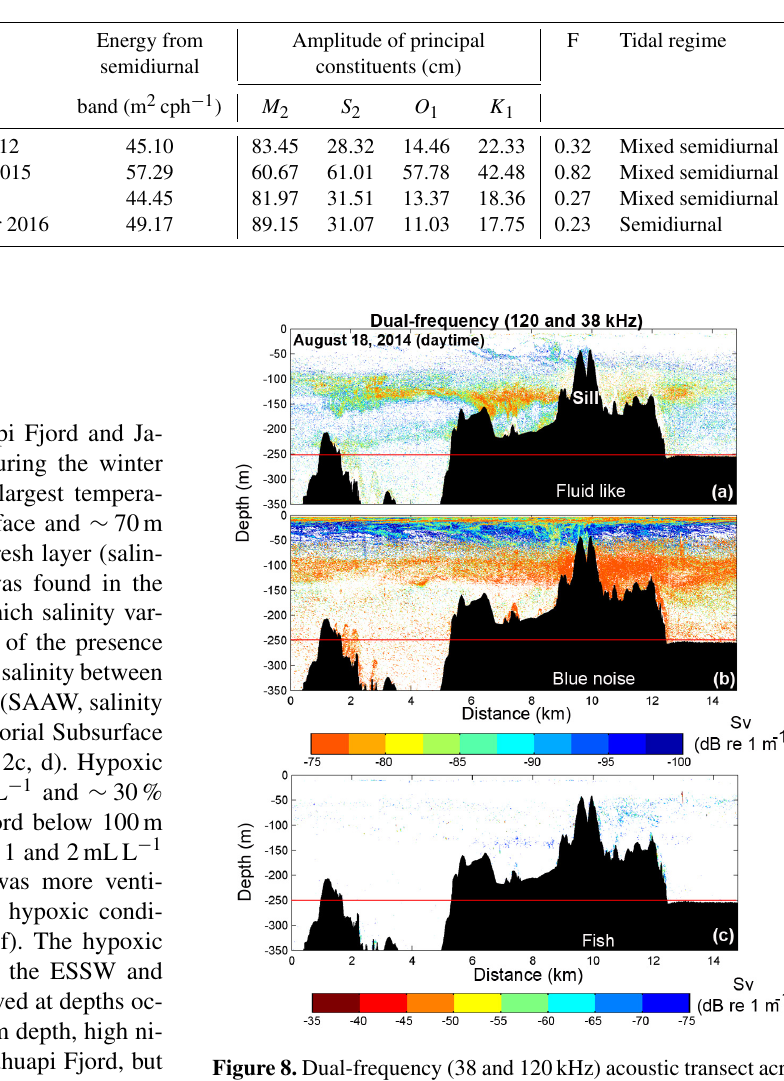
Figure 8. Dual-frequency (38 and 120kHz) acoustic transect across Jacaf sill conducted during daytime on 18 August 2014. (a) Fluid- like echogram, (b) blue noise echogram for zooplankton and (c) the fish echogram. Distribution indicated by colors representing S v val- ues. Horizontal red lines in (a, b, c) denote lower limits of usable acoustic data